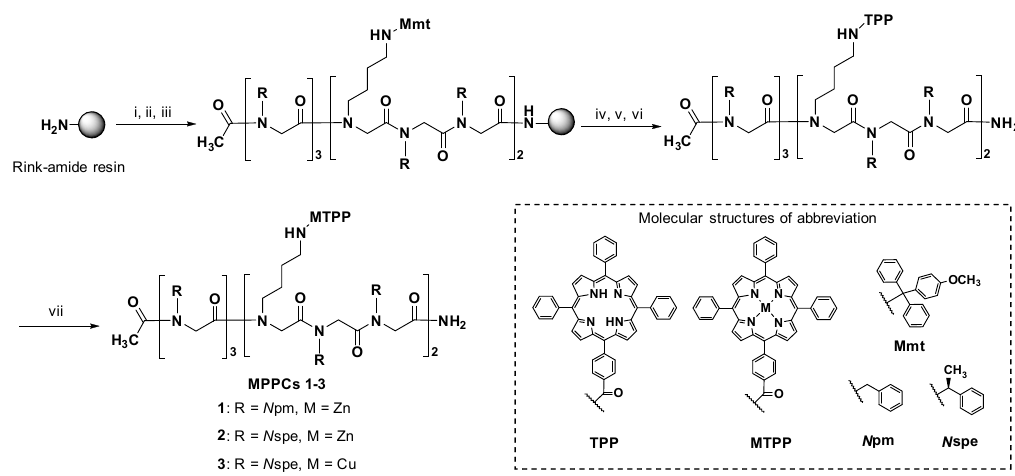
Scheme 1. Synthesis of metalloporphyrin–peptoid conjugates (MPPCs) 1 − 3 . Reagents and Conditions :